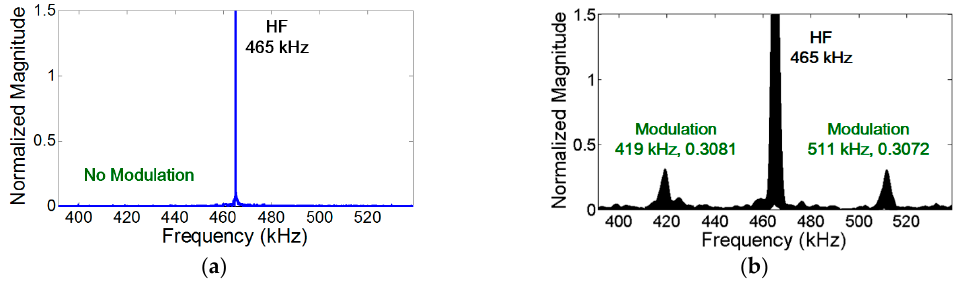
Figure 5. Experimental comparison of the effects of stationary vibration and propagating wave on the nonlinear modulation by converting LF input from a stationary sinusoidal input to a transient wave form. The modulation does not occur when the crack is located at the node of LF vibration mode. However, when the sinusoidal LF input is converted to a transient wave, the modulation appears. Here, both 46 kHz LF and 465 kHz HF modes are S 0 modes, and the synchronism condition is avoided to minimize the effect of distributed material nonlinearity. ( a ) Crack is located at the node of LF vibration mode and the anti-node of HF mode; ( b ) LF input is converted from a stationary sinusoidal input in (a) to a transient wave.